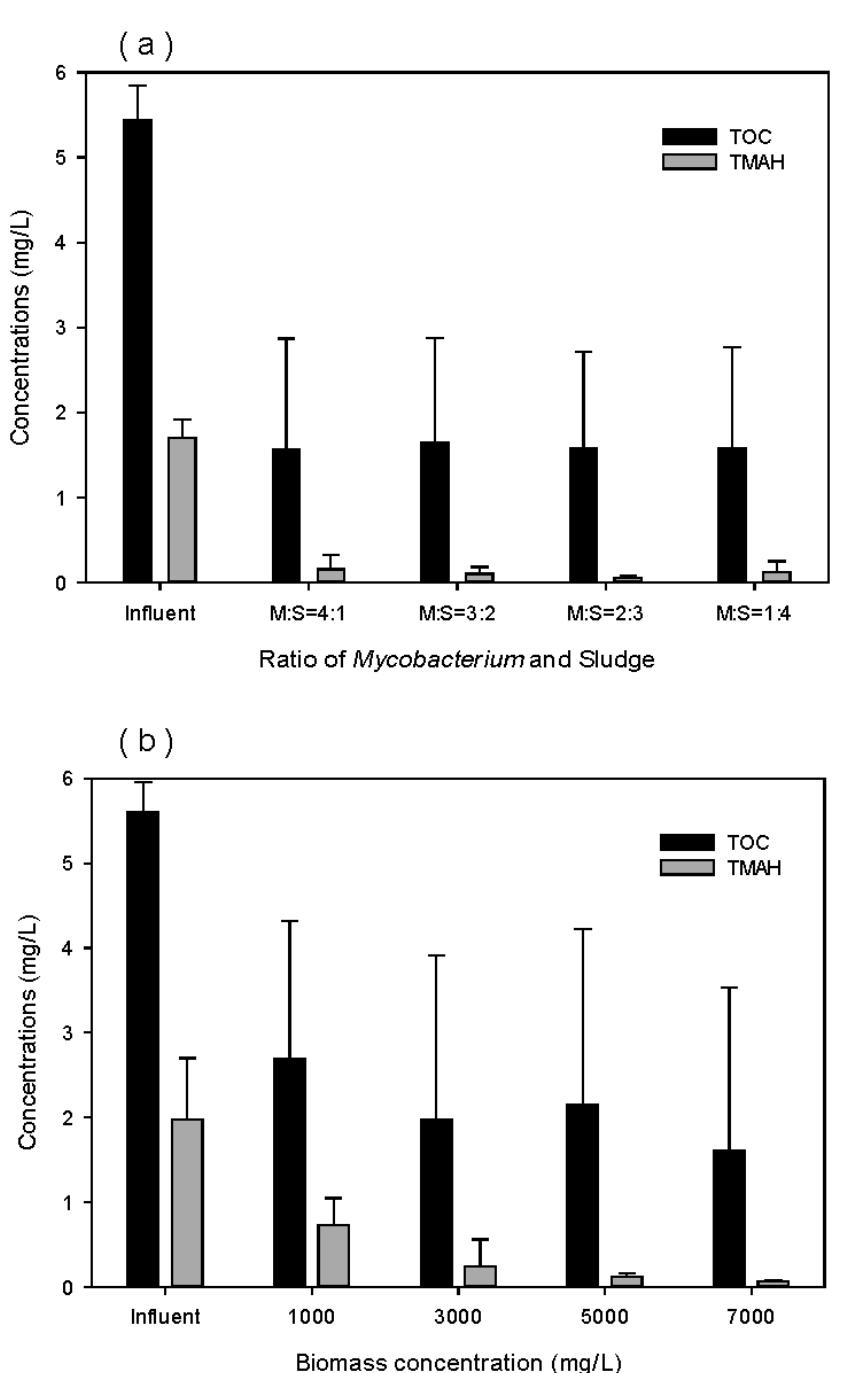
Figure 8. Removal e ffi ciencies of TMAH with di ff erent ( a ) ratio of Mycobacterium sp. to sludge, Figure 8. Removal efficiencies of TMAH with different ( a ) ratio of Mycobacterium sp. to sludge, and and ( b ) biomass ( b ) biomass concentration.